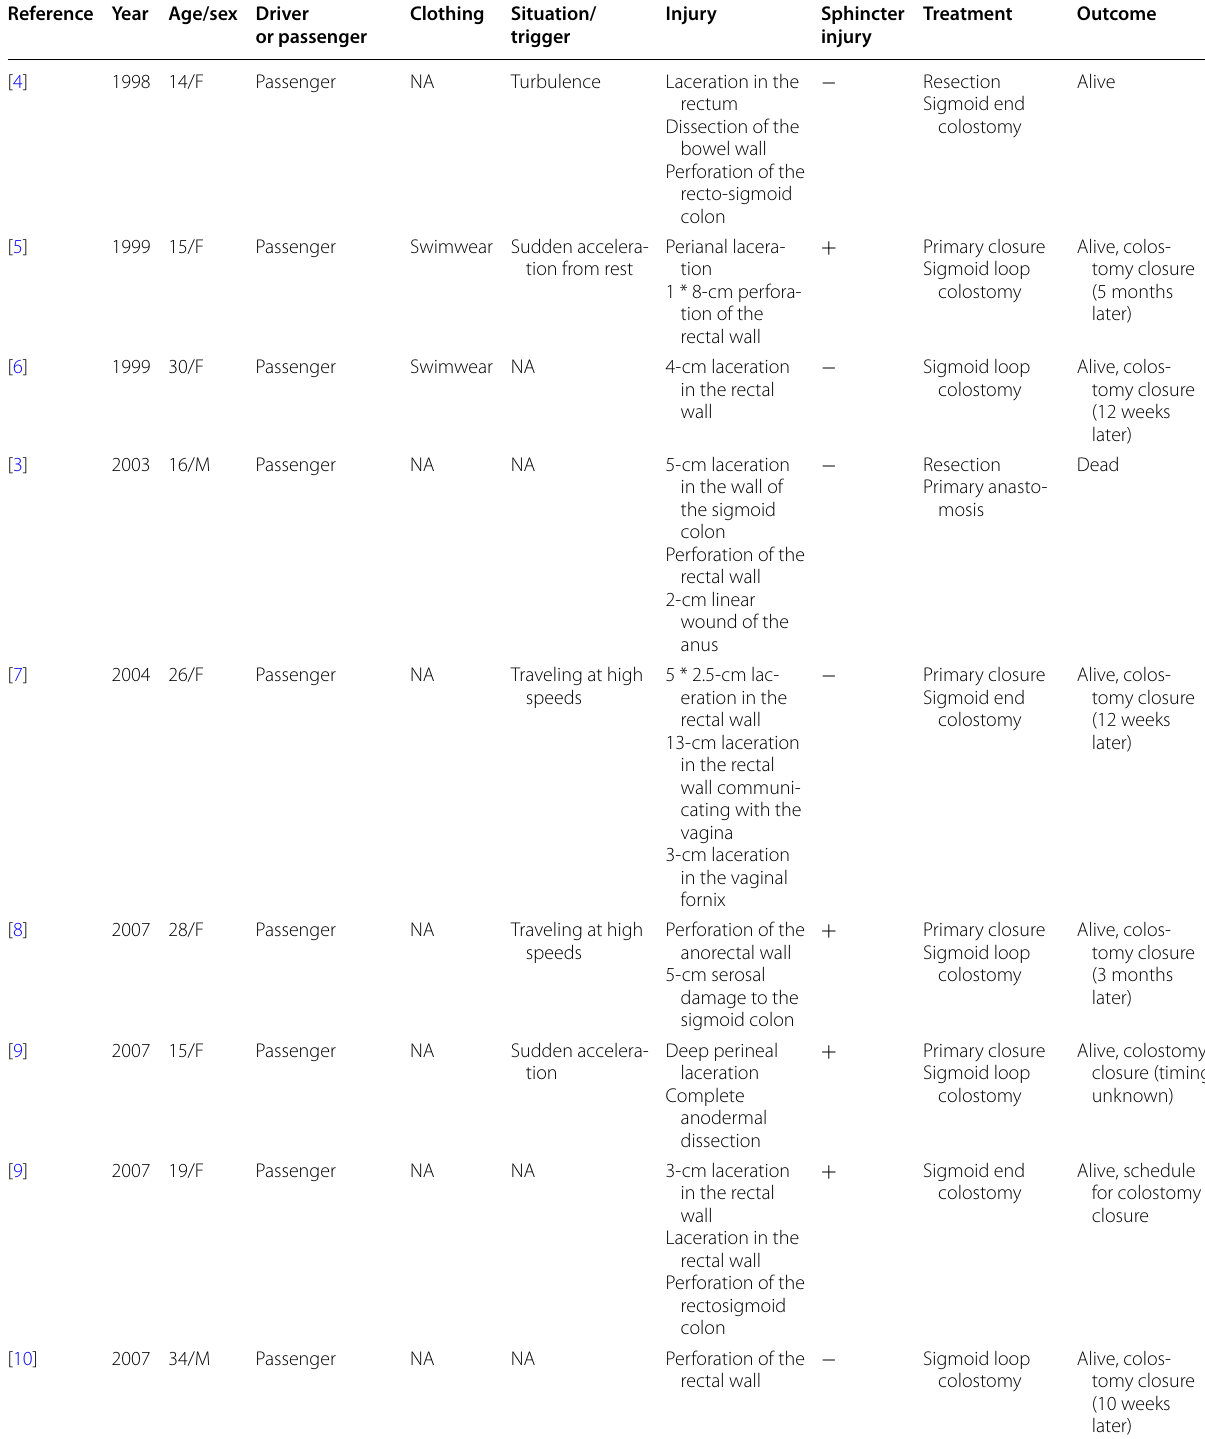
Table 1 Reported cases of anorectal injuries related to PWC use Reference Year Age/sex Driver or